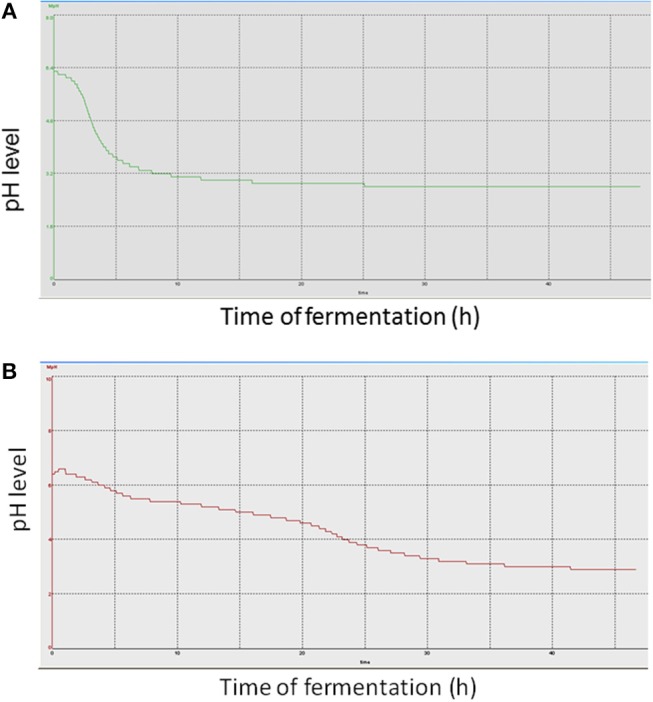
pH curve obtained in the fermentation of strains without pH control. (A) fermentation of BPL005; (B) fermentations of BPL013.